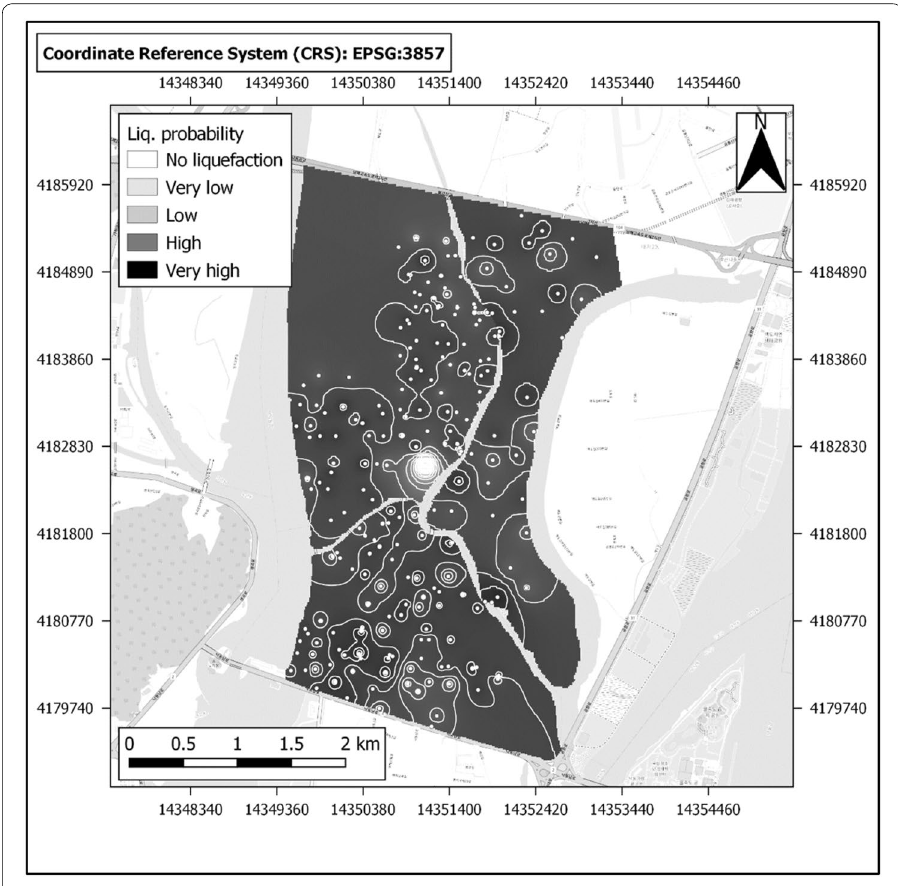
Fig. 24 Liquefaction hazard map based on reliability method for case